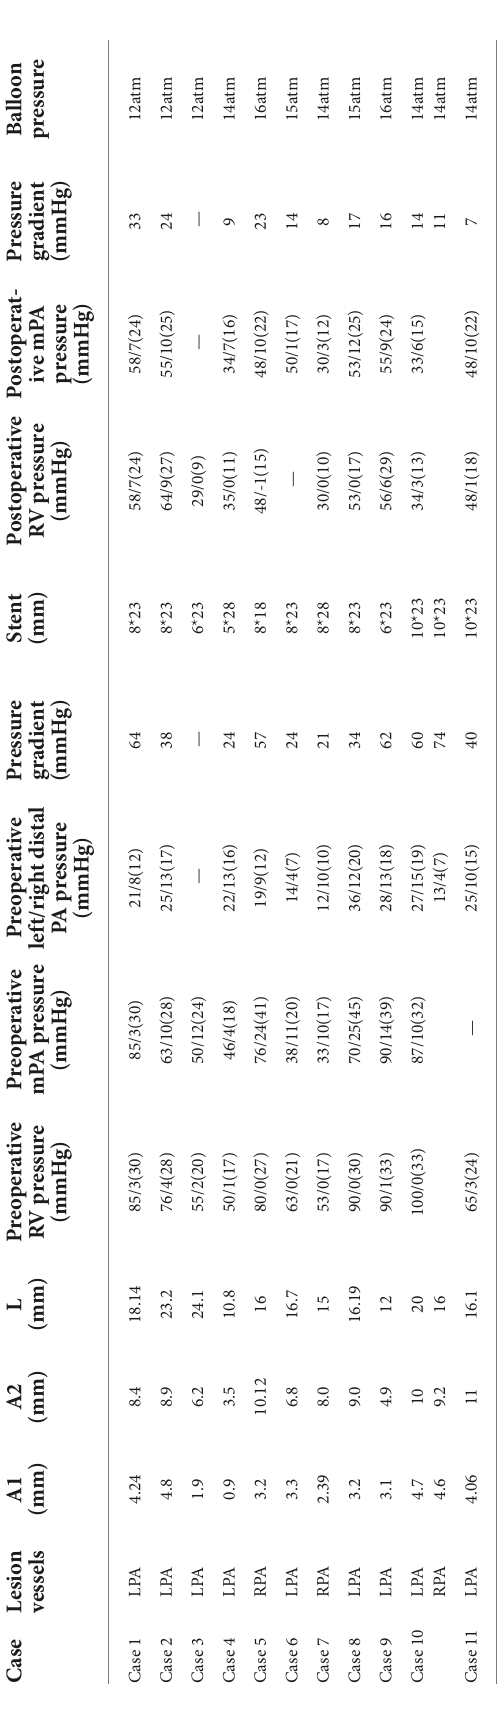
long axis systolic function. The normal range for the TV E/A ratio is 0.8–2.1 while a TV E/A < 0.8 may indicate impaired RV relaxation. A TV E/A > 2.1 may indicate restrictive RV filling while an E (cid:48) /A (cid:48) < 1 is abnormal and an E/E (cid:48) > 6 suggests elevated RA pressure. We also measured RVD1; this represents the mid RV diameter measured at the level of the RV papillary muscles. An RVD1 ≤ 42 mm in males or ≤ 35 mm in females, is considered normal. We also determined the RVD2:RV length, taken as the plane of the tricuspid annulus to the RV apex. An RVD2 ≤ 87 mm in males or ≤ 80 mm in females is considered normal. Echocardiographic parameters for the 11 patients are given in Table 6 while boxplots are shown in Figure 6 . Right ventricular systolic function parameters prior to stenting were as follows: S’ wave velocity ranged from 5 to 11 cm/s (mean: 8.44 ± 1.78 cm/s), TAPSE ranged from 9.7 to 18.7 mm (mean: 15.23 ± 3.45mm), and FAC ranged from 33 to 61% (mean: 42.2% ± 8.82%). Right ventricular diastolic function parameters prior to stenting were as follows: E/A ratio ranged from 0.67 to 2.00 (mean: 1.37 ± 0.35), E (cid:48) /A (cid:48) ratio ranged from 1.17 to 2.48 (mean: 1.84 ± 0.41), E/E (cid:48) ratio ranged from 3.17 to 11.60 (mean: 6.66 ± 2.29). Parameters of right atrial and right ventricle cardiac cavity size were as follows: right atrial transverse diameter ranged from 23.5 to 43.00 mm (mean: 30 ± 5.95 mm), RVD1 ranged from 25.5 to 33.0 mm (mean: 28.65 ± 2.61 mm), and RVD2 ranged from 23.7 to 65.00 mm (mean: 46.1 ± 12.6 mm). RVD1/RVD2 ranged from 0.46 to 1.11 (mean: 0.67 ± 0.21) and LVEF ranged from 64 to 81% (mean: 68.9% ± 5.96%). All of the patients had normal left ventricular systolic function. It was difficult to satisfy all of the indicators children’s right heart function because there are no gold standards. Compared with normal values, there were no statistical with regards to S’, TAPSE, or E/E (cid:48) for preoperative tests or tests carried out on day 1, month 1 and month 3 after implantation. However, significant differences were identified for FAC, E/A and E (cid:48) /A (cid:48) ( p < 0.01) ( Table 7 ). These results showed that the 11 cases had normal right ventricular systolic and diastolic function before and after stenting. We also found that there was no statistical difference in any of the ultrasound parameters when compared before stenting and day 1 post-stenting. One month post-stenting, FAC and E (cid:48) /A (cid:48) were statistically different from those before stenting ( p = 0.041 and p = 0.035). Three months post-stenting, only E/A showed a statistical difference ( P = 0.015) ( Table 6 ). Based on correlation analysis of echocardiographic parameters, TAPSE correlated significantly with S’ ( r = 0.393; p = 0.008) and LVEF ( r = 0.513; p < 0.01), E/E (cid:48) correlated significantly with E (cid:48) /A (cid:48) ( r = 0.391; p = 0.009), RA volume correlated significantly with RVD1 and RVD2 volume ( r = 0.44; p = 0.003 and r = 0.573, p < 0.01, respectively), and RVD1 volume correlated significantly with RVD2 volume ( r = 0.44, p = 0.003) ( Figure 7 ). Table 8 shows tricuspid and pulmonary valve regurgitation. Before stenting, no tricuspid valve regurgitation was in